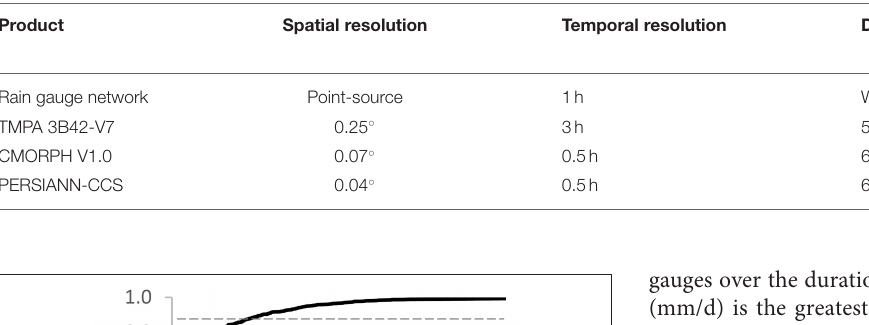
TABLE 2 | Summary of the characteristics of precipitation data used in this study.